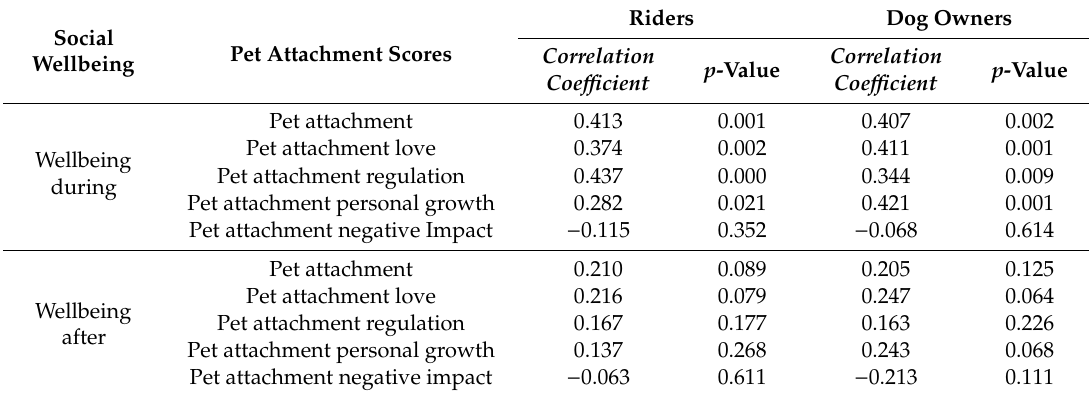
Table 5. Spearman correlation of social wellbeing and pet attachment